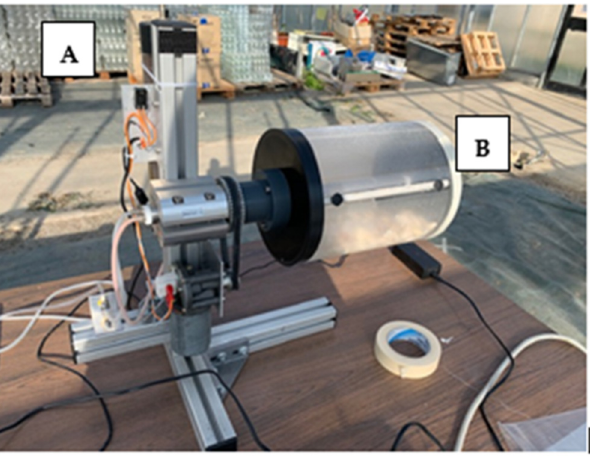
Figure 3. Prototype machine used in in vivo trials with ozone. ( A ) Ozone generator; ( B ) Treatment chamber, a cylinder where the ozone is delivered.